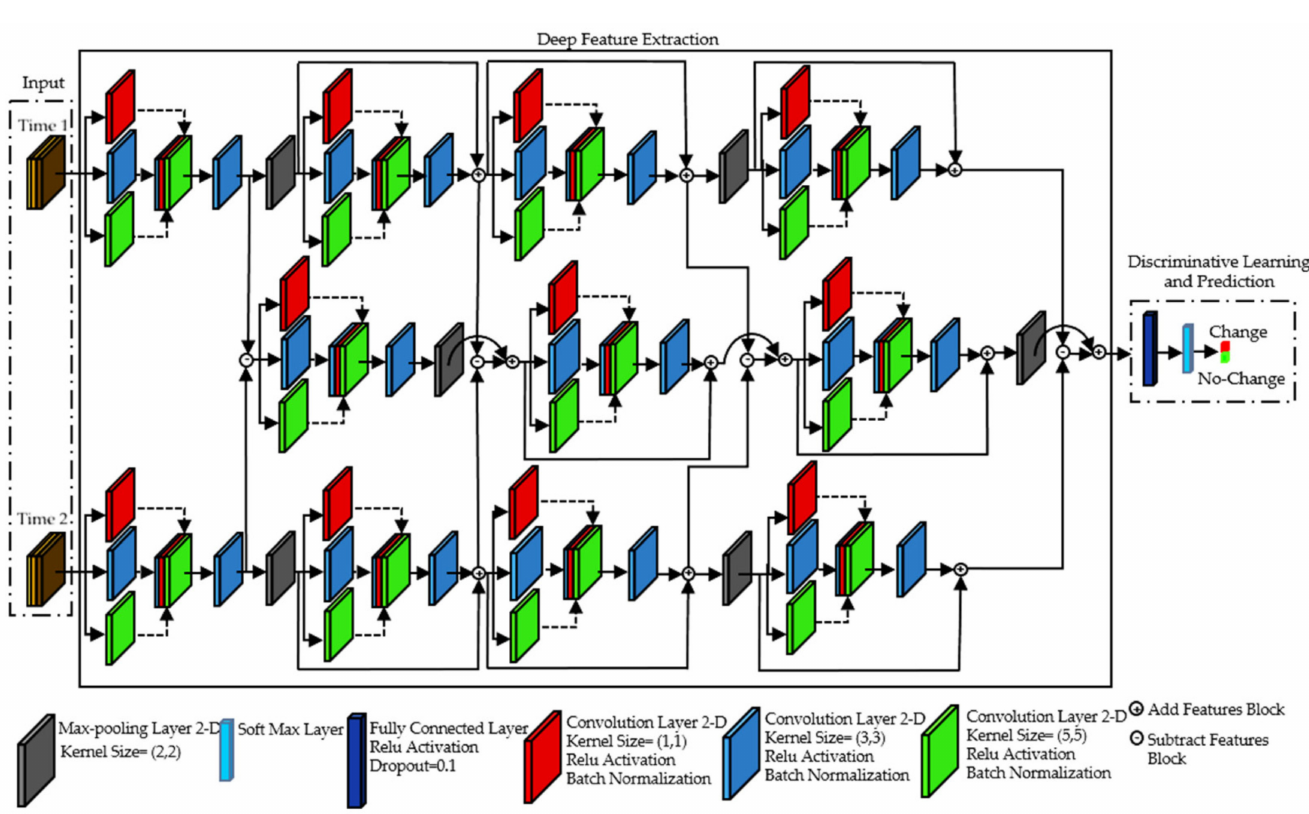
Figure 5. The proposed TCD-Net architecture for CD of remote sensing (RS)